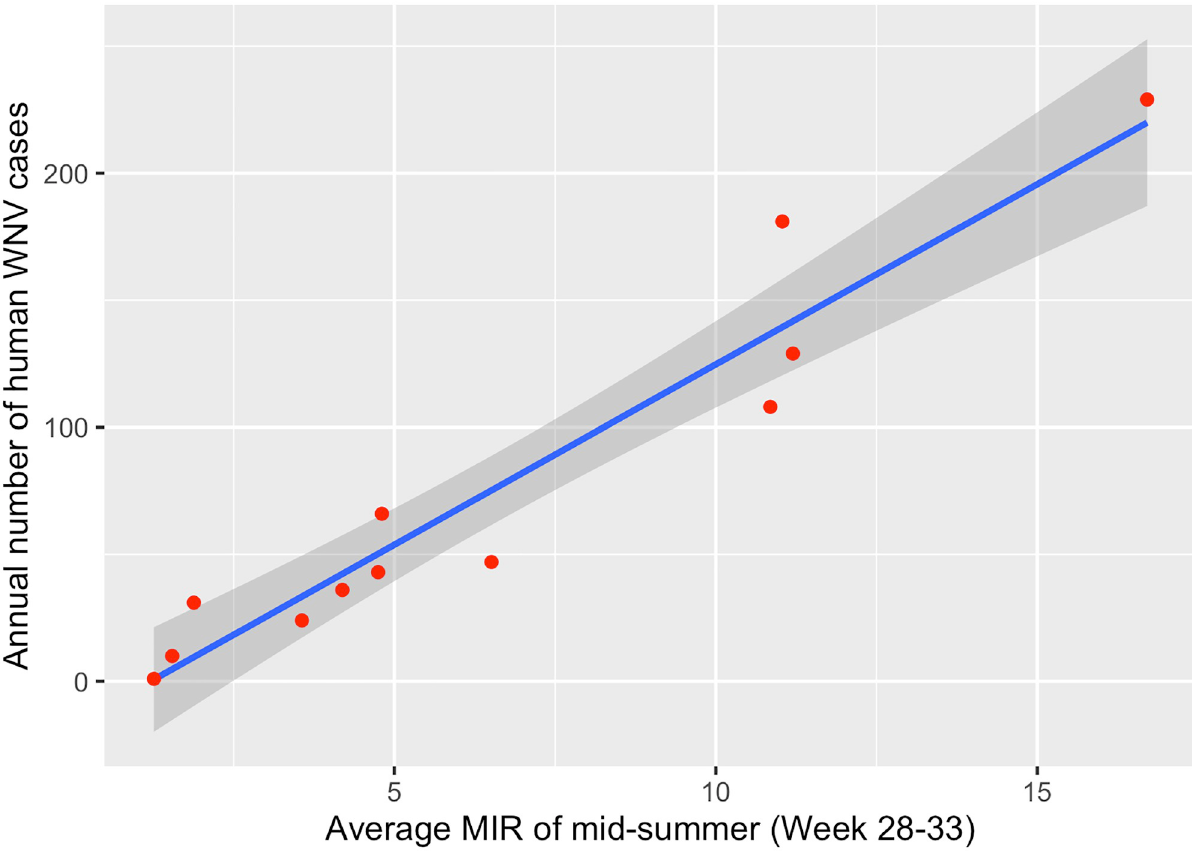
Fig 2. The relationship between annual human WNV infections and mid-summer mosquito infection rate from 2005–2014 in Cook and DuPage counties, Illinois. Blue line indicates the best-fit linear regression line, with gray shading indicating 95% confidence intervals. Red points are observations (one per